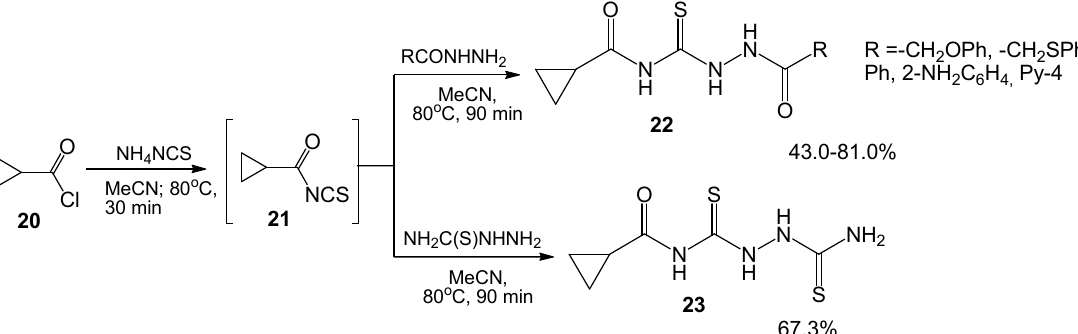
Fig. 6. “One-pot” synthesis of diacylsemicarbazides and hydrazine-1,2-bis(carbothioamide) with cyclopropane